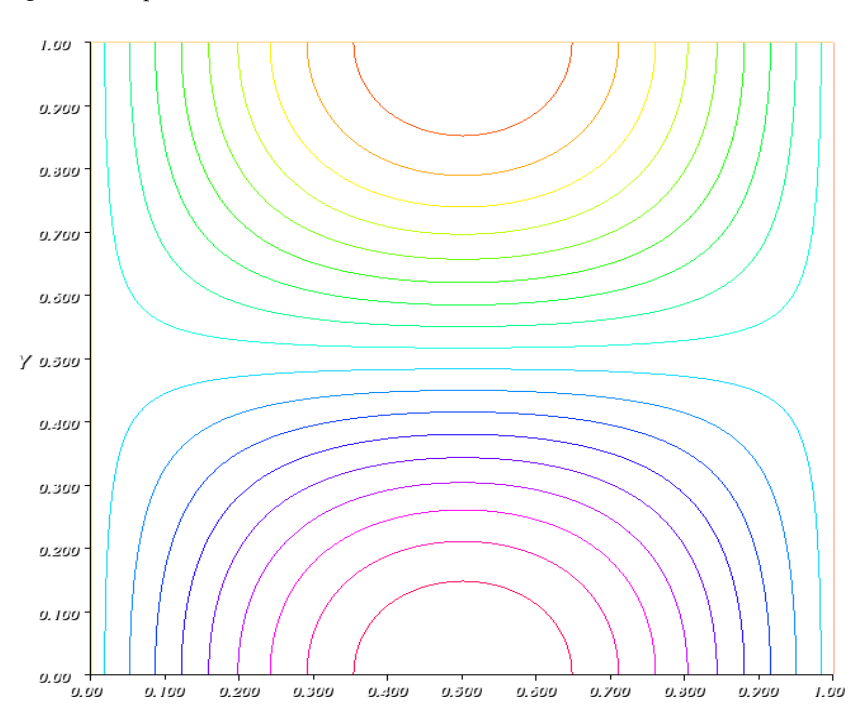
Figure 4. The magnetic field